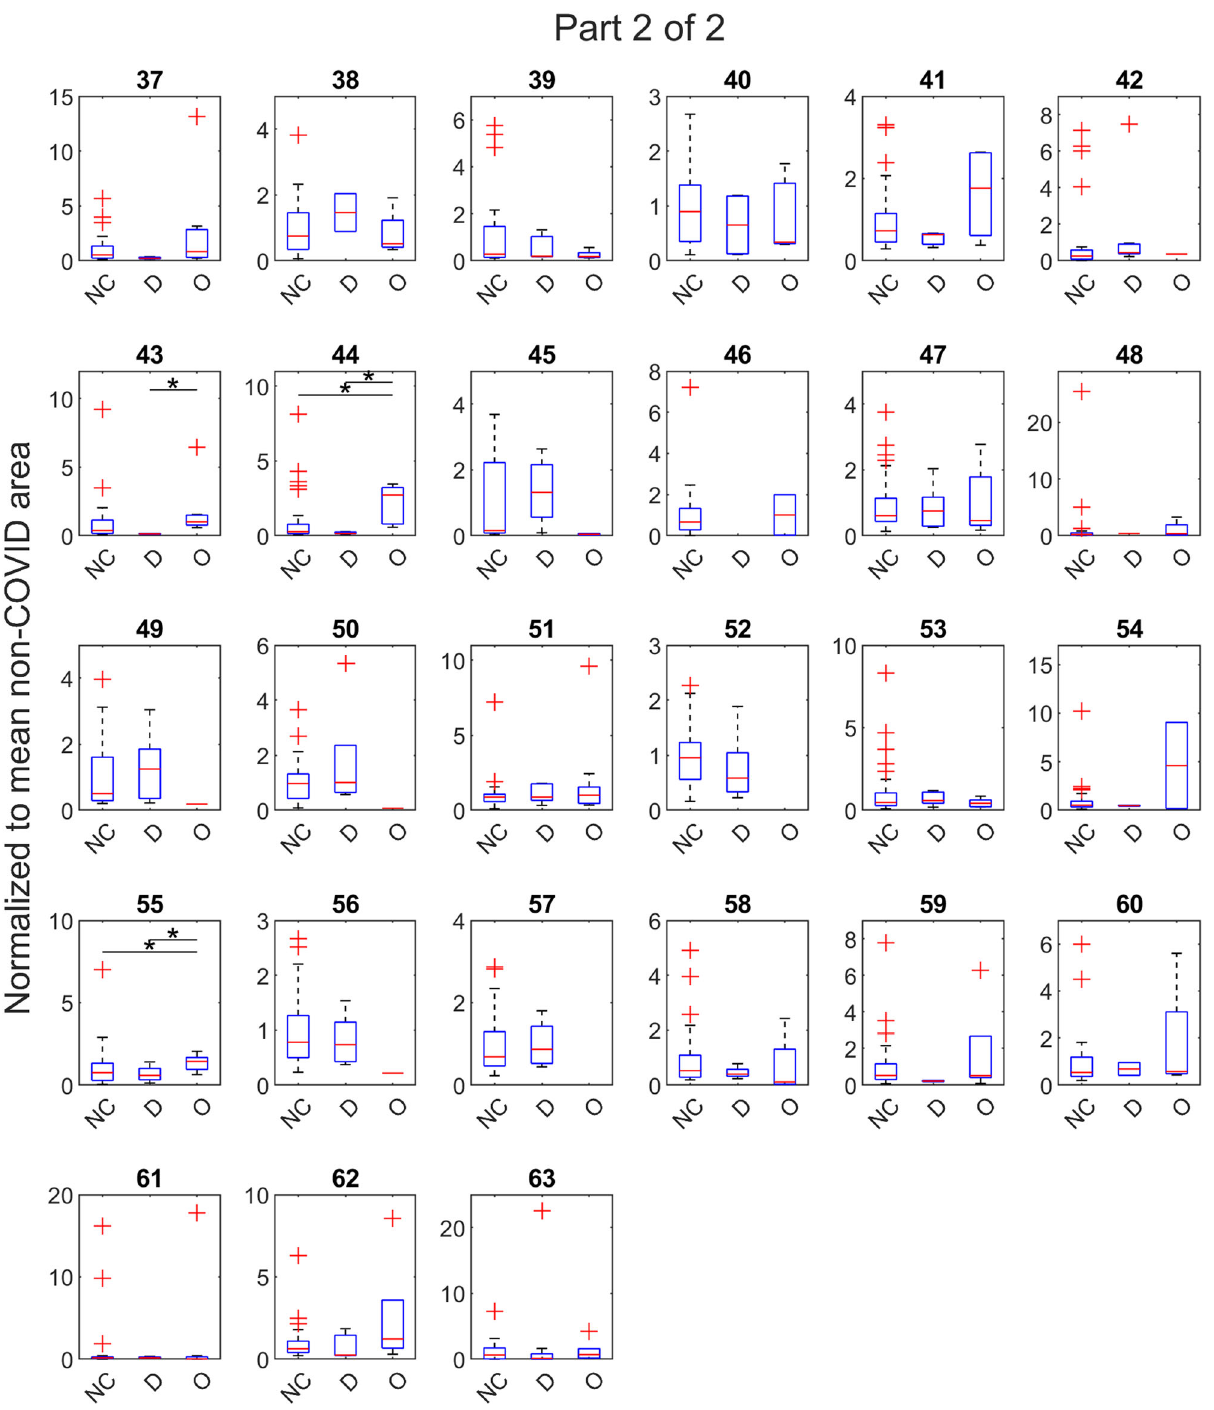
Fig. 3 Abundances of exhaled volatile compounds considered by breath-based models to predict COVID-19 infection (see also Fig. 2). Boxplots representing the abundances of the 63 volatile organic compounds (VOCs) (continued in Fig. 2) used by partial least squares-discriminant analysis (PLS- DA) models to differentiate breath samples of non-COVID (NC) controls, n = 96, from COVID( + ) samples collected during the Delta (D), n = 12, and Omicron (O), n = 28, waves. For each compound, the data were normalized to the mean intensity from non-COVID controls, so y -axis values represent the number of times greater relative to the mean non-COVID abundance. Asterisks indicate signi fi cant differences per a Kruskal – Wallis test between two groups (* p < 0.05, ** p < 0.01). See Supplementary Data 2 to map compound number to putative identi fi cation. The central red line indicates median, bottom and top edges indicate 25th and 75th percentiles, respectively, whiskers extend to the most extreme non-outlier data points, and outliers are plotted with the red ‘ + ’